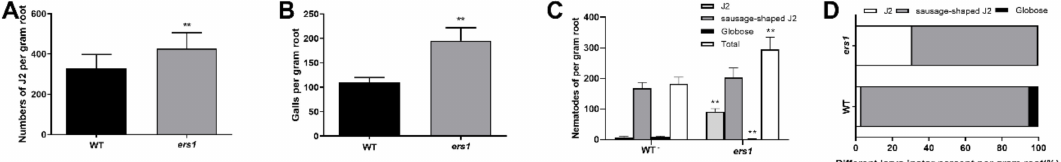
Figure 7. Altered disease resistance of ers1 plants against RKNs. ( A ) Numbers of J2 in the roots of the ers1 mutant at 6 d after RKN inoculation (SD, n = 16). ( B ) Numbers of root galls in the ers1 mutant at 18 d after RKN inoculation (SD, n = 16). ( C , D ) Numbers and percentages of di ff erent larval instars in the ers1 mutant at 18 d after RKN inoculation (SD, n = 16); * p < 0.05, ** p <